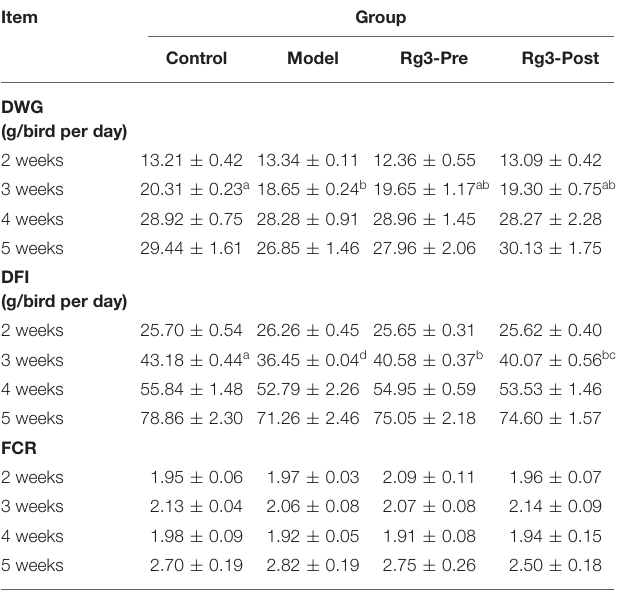
TABLE 4 | Growth performance (experiment 2).